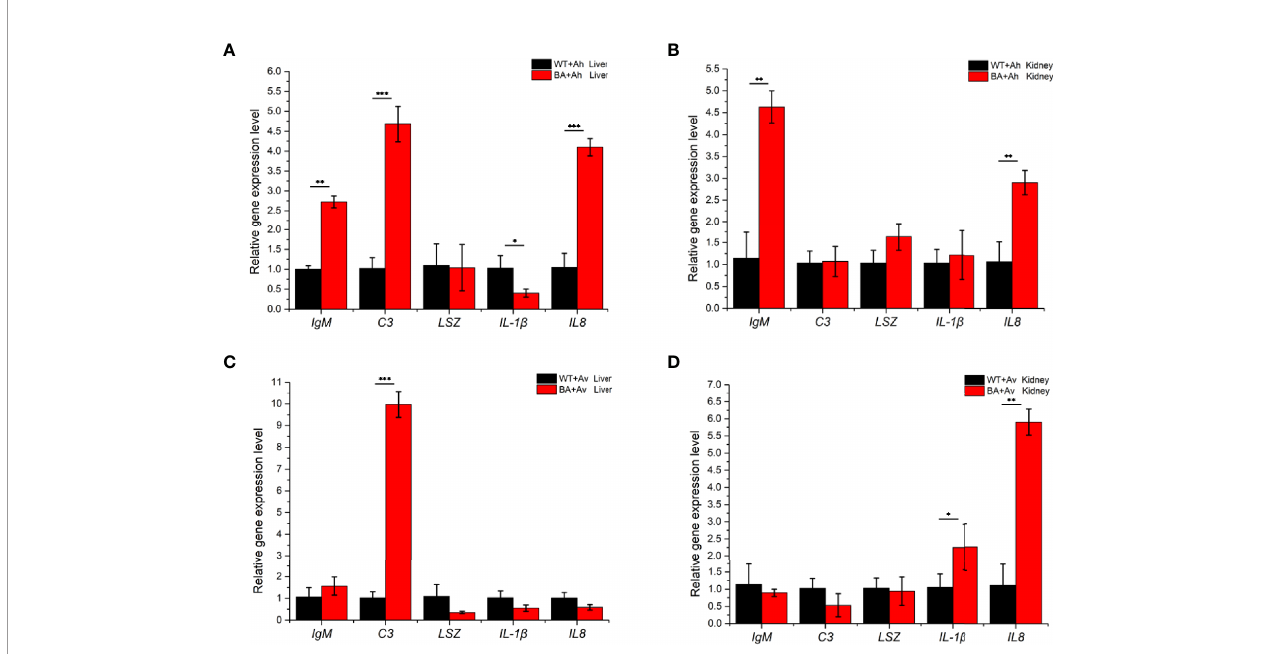
FIGURE 8 | Analysis of immune-related gene expression in grass carp that fed with BaX030 after infection with AhX040 and AvX005. (A, B) Expression of immune- related genes in the liver and kidney after infection with AhX040; (C, D) The gene expression levels of immune-related cytokines in liver and kidney at post-infection AvX005. WT+Ah: grass carp+AhX040; BA+Ah: grass carp + BaX030+AhX040; WT+Av: grass carp+AvX005; BA+Av: grass carp + BaX030+AvX005. Datas were mean ± SEM for n=4 biologically independent experiments. Statistical analysis were performed using one-way ANOVA. *** P < 0.001; ** P < 0.01; * P <